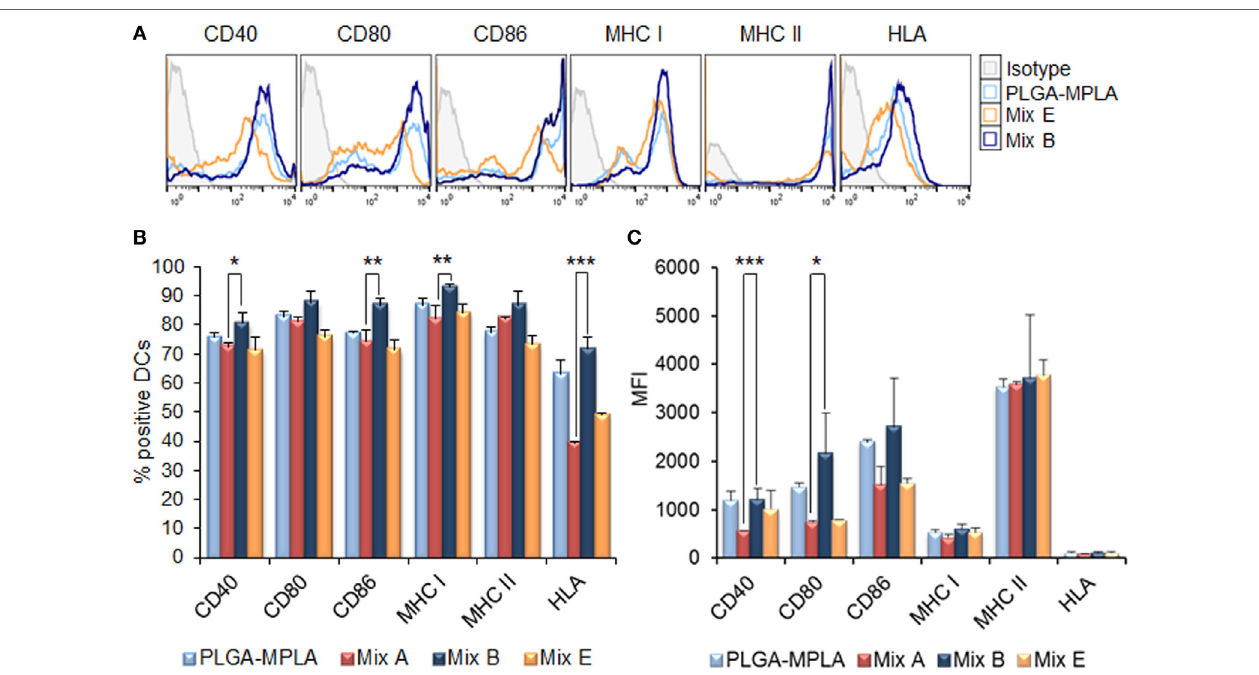
FigUre 3 | Monophosphoryl lipid A (MPLA) incorporation in peptide-based poly(lactic- co -glycolic) acid (PLGA) nanoformulations further enhanced the maturation of dendritic cells (DCs) from HLA A2.1 transgenic mice. DCs were cultured for 24 h upon stimulation with the mix of PLGA-chCPAp-MPLA, PLGA-chH1p-MPLA, and PLGA-KMP-11p-MPLA nanoformulations (mix B), the mix of soluble chimeric peptides with MPLA adjuvant (mix E), or PLGA nanoparticles with MPLA encapsulated. (a) Representative histogram plots of CD40, CD80, CD86, major histocompatibility complex (MHC) class I, and class II molecules levels. (B) Diagram demonstrating the percentage (%) of DCs expressing the co-stimulatory and MHC class I and class II molecules. (c) Diagram demonstrating the mean fluorescence index (MFI) of DCs expressing the co-stimulatory and MHC class I and class II molecules. Results are expressed as the mean ± SD of three independent experiments. Significant differences are indicated by * p < 0.05, ** p < 0.01, or *** p <